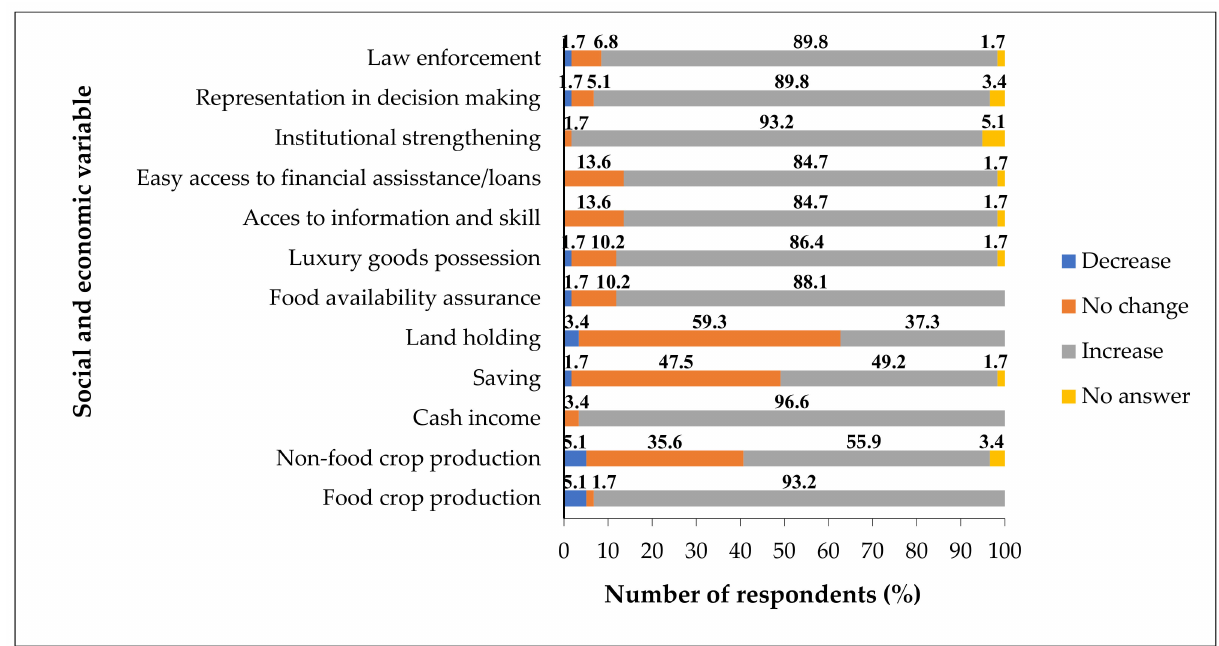
Figure 8. Impact of agroforestry development on socio-economic status of the community in WAR